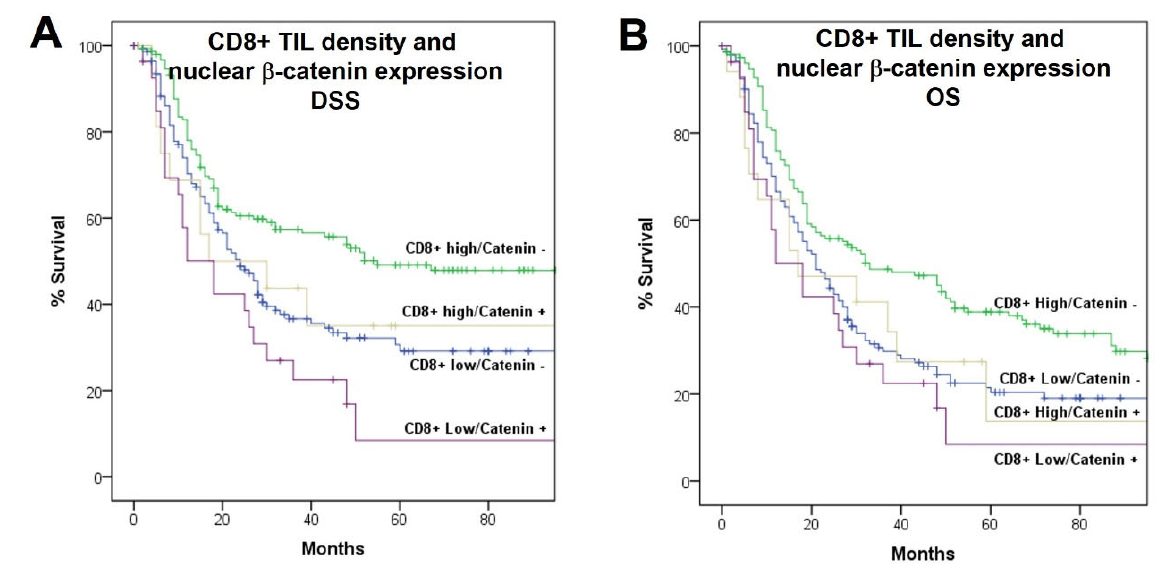
Figure 3. Kaplan–Meier-disease-specific ( A ) and overall survival ( B ) curves according to the com- bined expression of nuclear β -catenin and CD8+ TIL